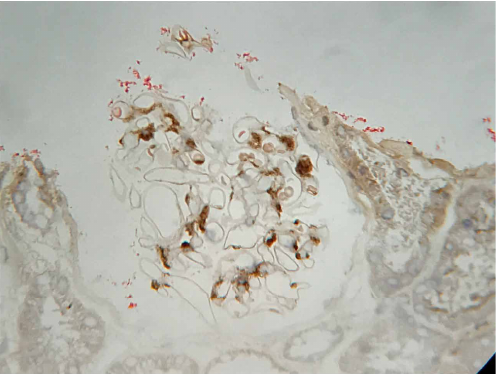
Figure 4: Mesangial C3 deposition was